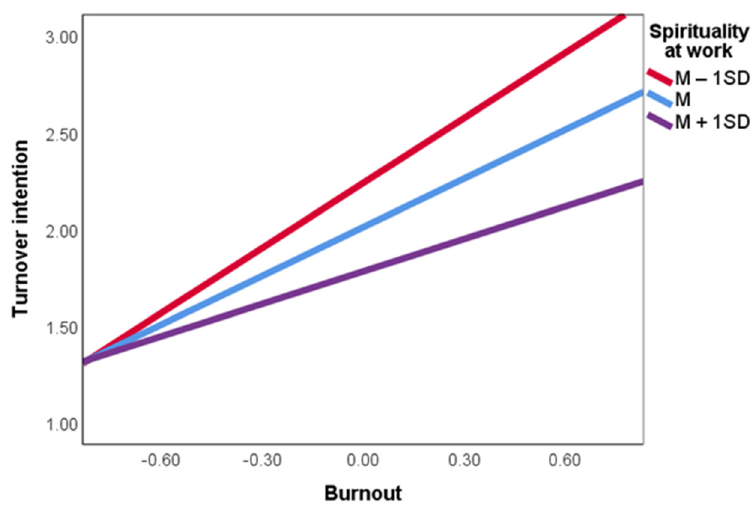
Figure 3. Model 59a: Moderating effect of spirituality on the relationship between burnout and turnover intention. M − 1 SD = one standard deviation below the mean; M = mean; M + 1 SD = one standard deviation above the mean. Burnout and spirituality were mean-centered before creating a product term.